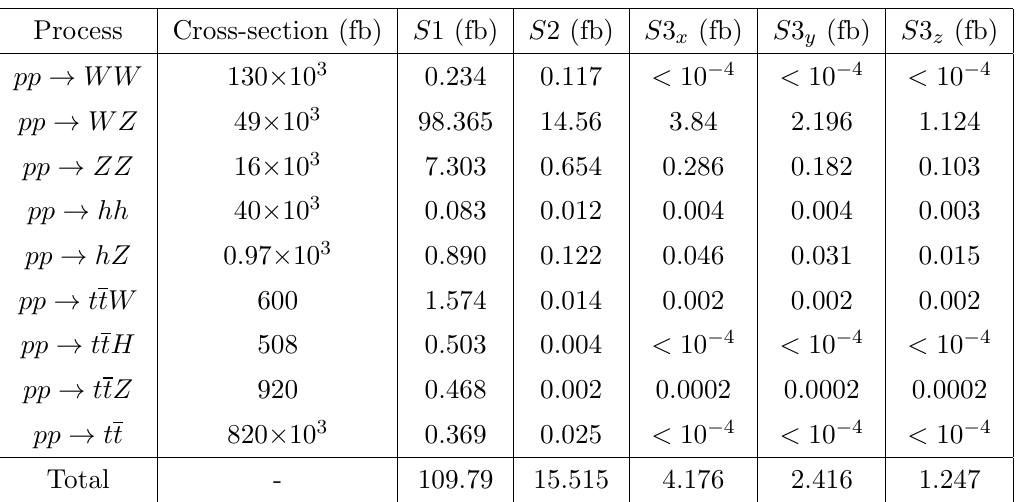
qq(cid:31) Q ) = 0.67. !